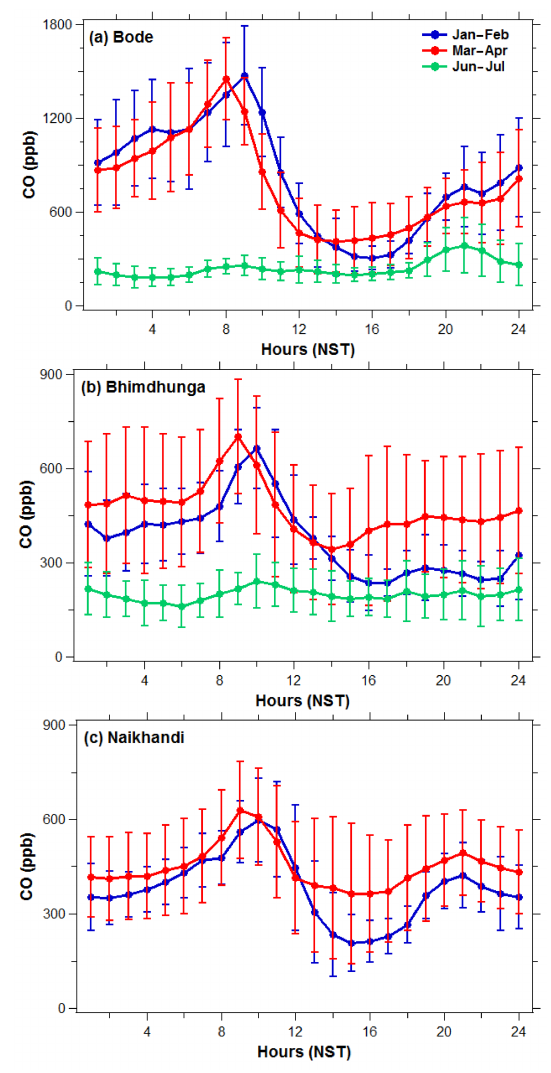
Figure 4. Comparison of diurnal variation of hourly average CO mixing ratios for four seasons at Bode, Bhimdhunga and Naikhandi. Due to the lack of continuous data at some sites, data of 1 month in each season were taken for comparison as representative of the winter (16 January–15 February), premonsoon (16 March–15 April) and monsoon (16 June–15 July) season of 2013. Note: y -axis scale of the top panel (Bode) is double that of the lower two panels (Bhimdhunga and